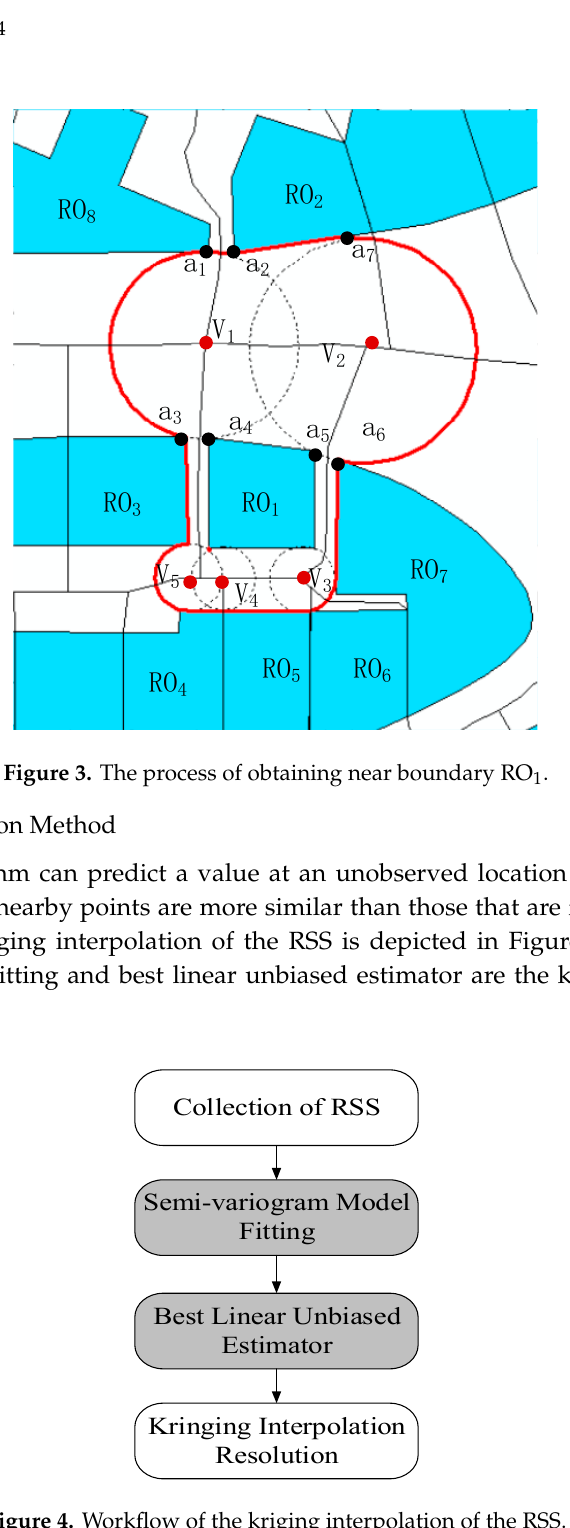
Figure 4. Workflow of the kriging interpolation of the RSS.